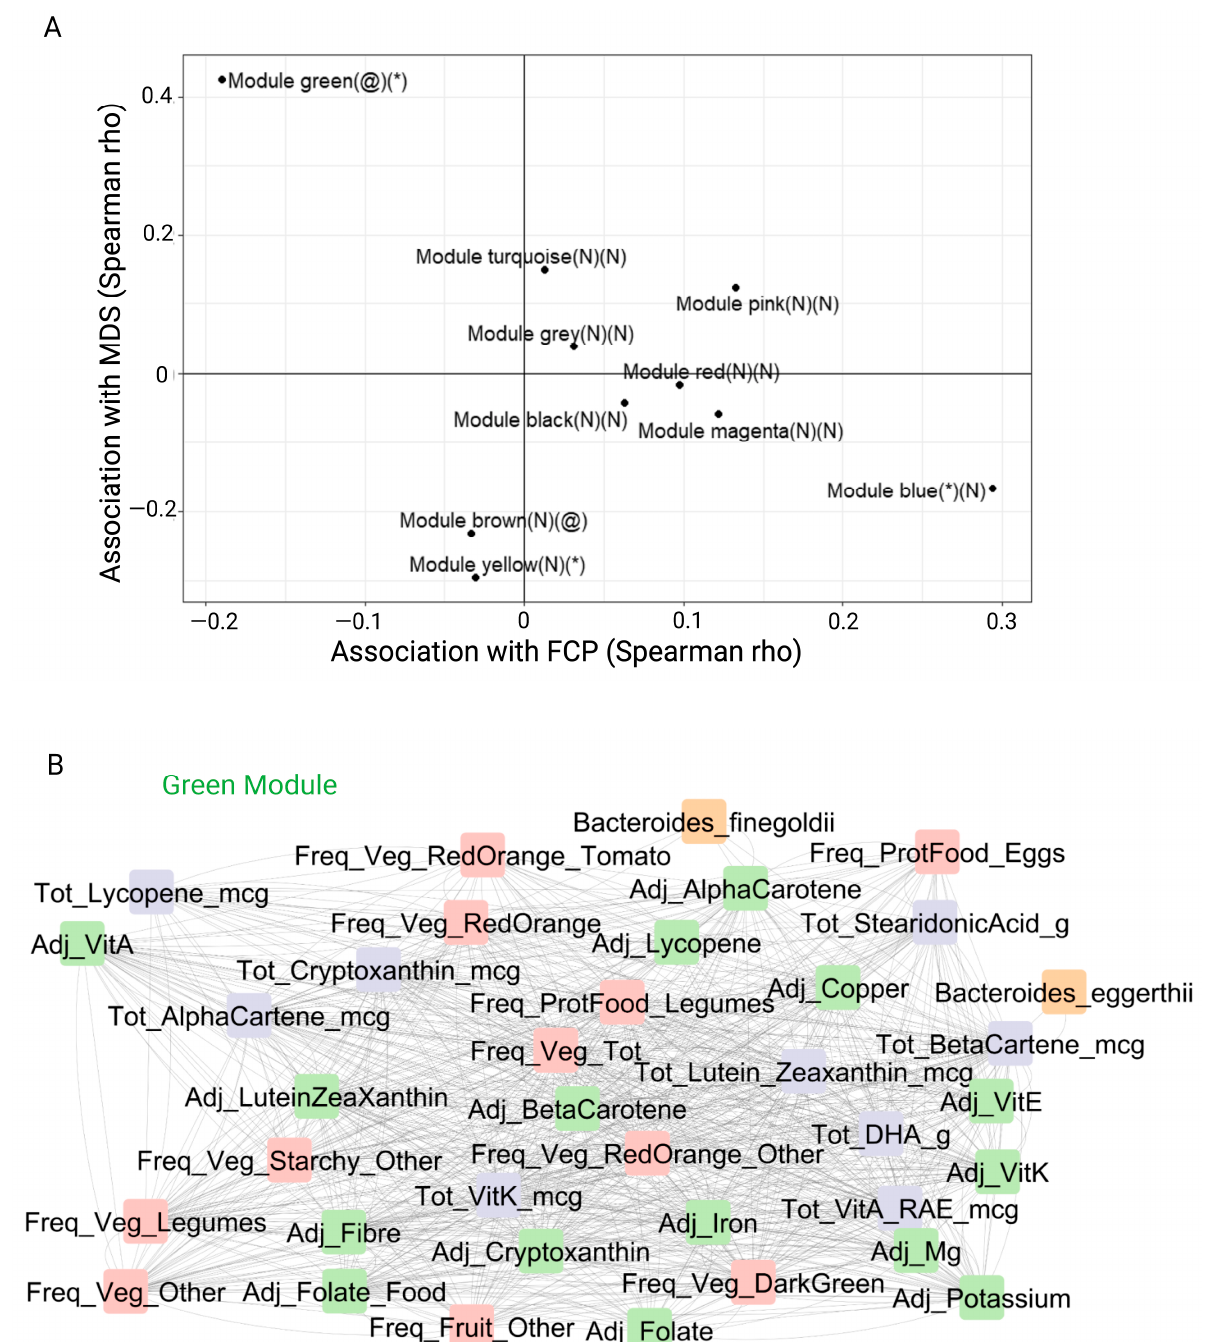
Figure 3. Associating module eigengenes with fecal calprotectin and Mediterranean diet score. ( A ) The Spearman’s rho inter-correlation between cluster eigengenes. Significance level: * p < 0.05, @ p < 0.10, N = not significant. ( B ) The negative association with fecal calprotectin (green module) encompasses specific nutrients, foods and Bacteroides species. Freq refers to the frequency of food groups (shown in pink); Tot refers to the macronutrient and micronutrients calculated per day (shown in purple); Adj refers to macronutrients and micronutrients calculated per 1000 kilocalories (shown in green); Bacteroides species (shown in orange). Abbreviations: MDS, Mediterranean diet score; FCP, fecal calprotectin; Veg, vegetables; Mg, magnesium; DHA; docosahexaenoic acid, Vit, vitamin; Prot, protein; mcg, micrograms; g, grams; RAE, retinol activity equivalents; BetaCartene,